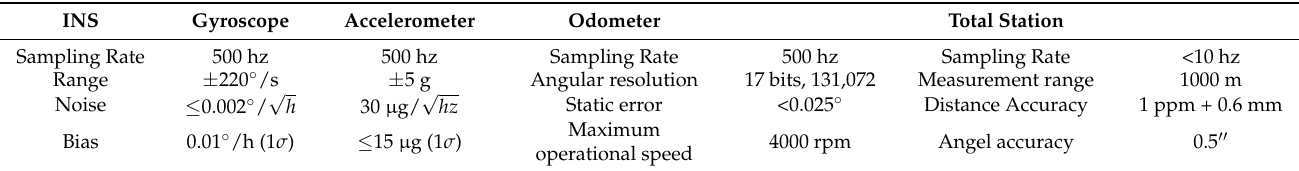
Table 1. Parameters of sensors on the wheeled